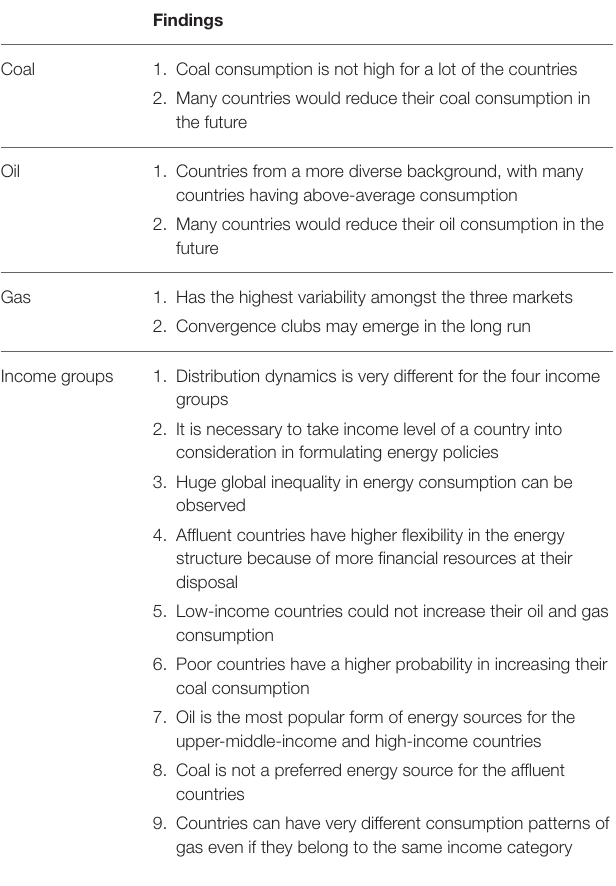
TABLE 3 | Summary of major